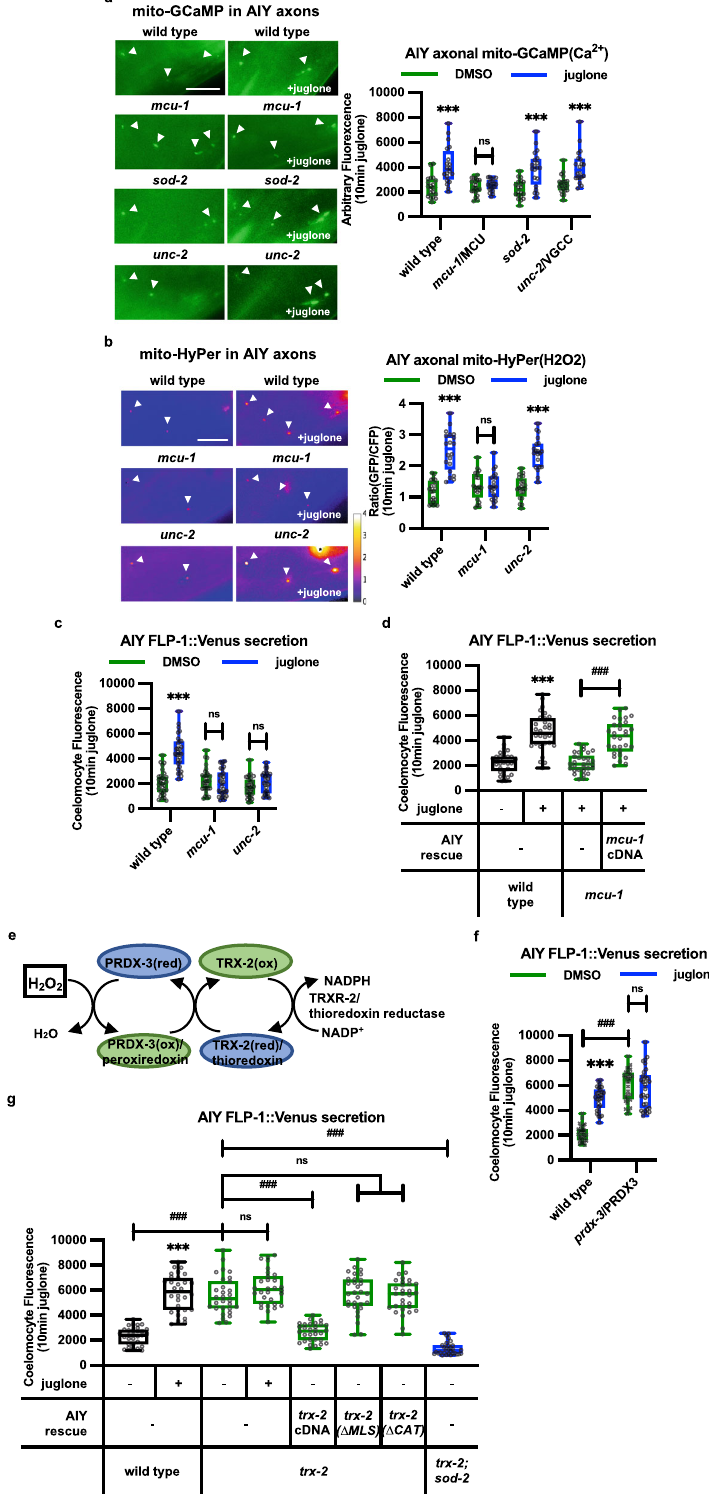
ric-7 mutations signi fi cantly reduced baseline FLP-1::Venus secretion from AIY compared to wild-type controls, consistent with its reported role in positively regulating DCV secretion 108 . In addition, ric-7 mutations abolished juglone-induced FLP-1:: Venus secretion (Fig. 6b). Expression of a chimeric protein (UNC-116::TOM-7, aka mito-truck), which functions as an adapter between mitochondria and microtubules that can restore